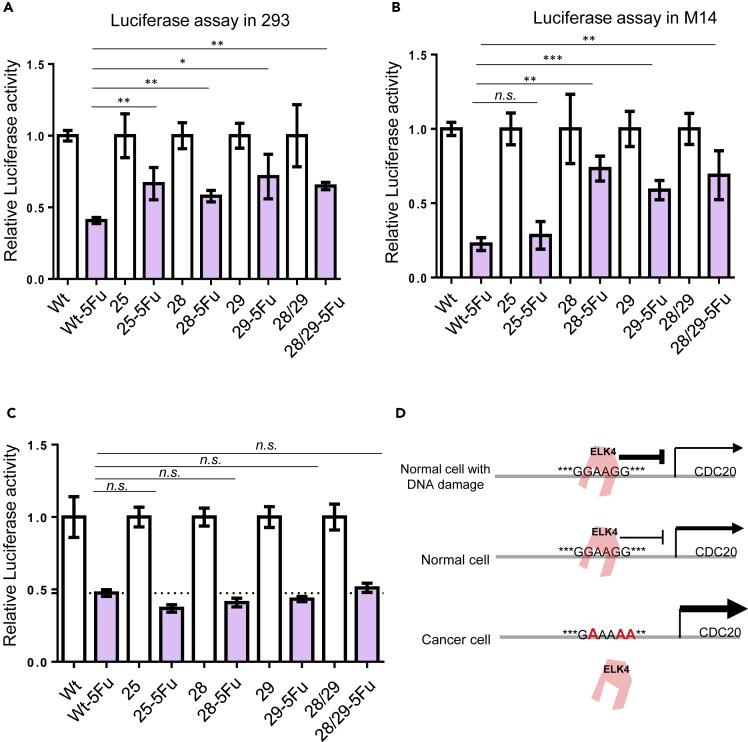
Hotspot mutation targeted sequence mediates DNA damage-induced CDC20 transcriptional repression(A and B) Luciferase reporter assay was performed in 293 (A) or M14 (B) cells with wild-type or mutant CDC20 promoter driving luciferase vectors in the presence or absence of DNA damage drug 5-FU. ∗p < 0.05, ∗∗p < 0.01, ∗∗∗p < 0.001, Student's t test compared with wild-type. The results are an average of three independent experiments. Values are mean ± SD.(C) Luciferase reporter assay was performed in ELK4 shRNA knockdown 293 cells with wild-type or mutant CDC20 promoter driving luciferase vectors in the presence or absence of 5-FU.(D) Proposed function for the hotspot mutation targeted sequence in CDC20 transcriptional regulation.